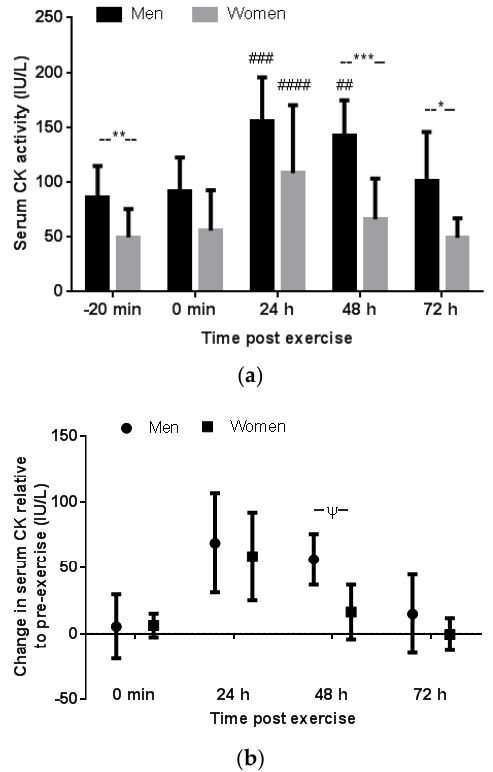
Figure 1. Gender comparison of the absolute serum creatine kinase (CK) activity pre- and post downhill running expressed as mean ± SD ( a ); and the magnitude of CK response post downhill running expressed as the average change relative to pre-exercise and 95% confidence interval ( b ). ##, ### and #### denotes a significant difference relative to pre-exercise (–20 min) within a group, p < 0.01, p < 0.001 and p < 0.0001, respectively. *, ** and *** denotes a significant difference between groups at that time point, p < 0.05, p < 0.01 and p < 0.001, respectively. ψ denotes a trend for difference between groups at this time point, p = 0.08.